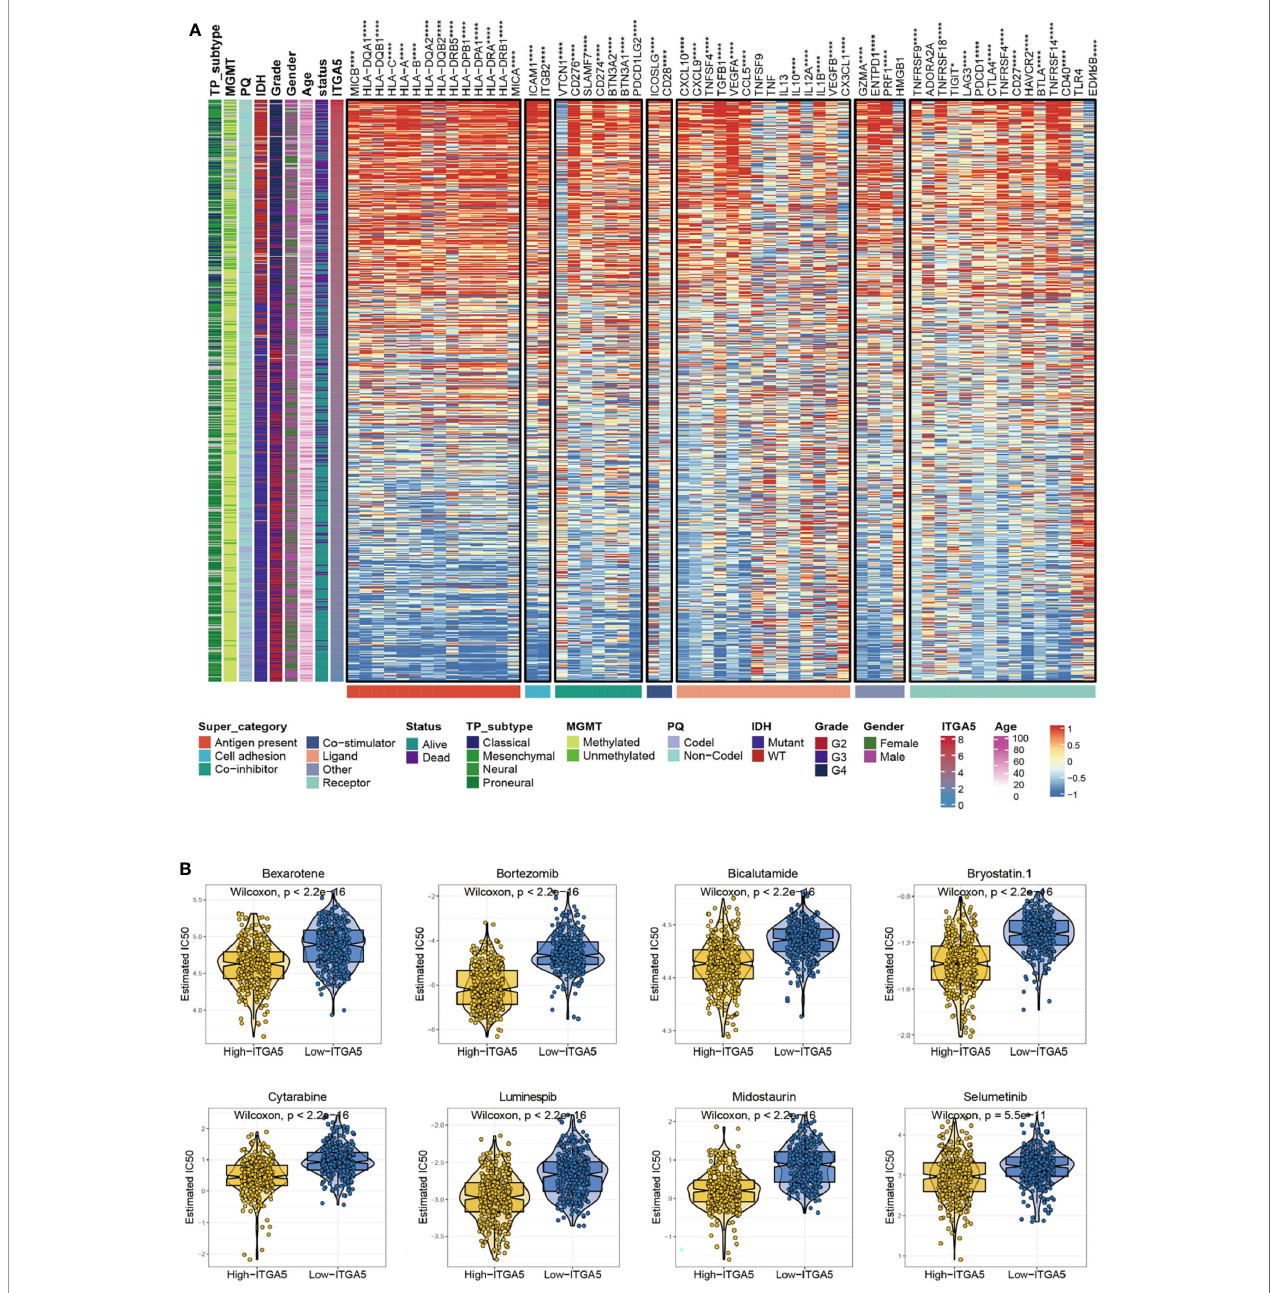
FIGURE 7 | The potential ITGA5-involved immune checkpoints treatment and chemotherapeutic targets in gliomas. (A) Correlations between ITGA5 and seven types of immune checkpoints levels in gliomas. *P <0.05, **P <0.01, ***P <0.001, ****P <0.0001. (B) The box plots of the estimated IC50 for several chemotherapeutic drugs among high-ITGA5 and low-ITGA5